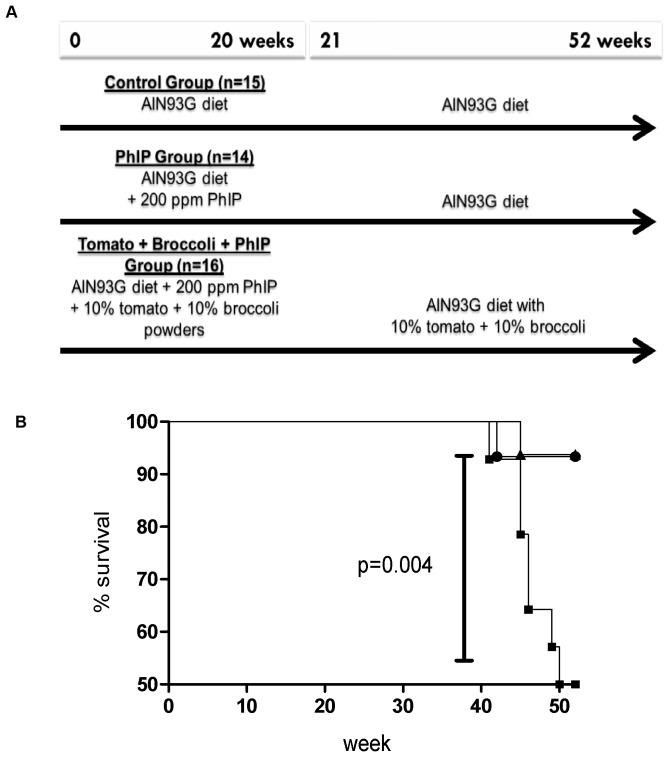
Study design and survival curve for 52 week study.A) Study design B) Survival curve. Control (•); PhIP (▪); tomato + broccoli + PhIP (▴).